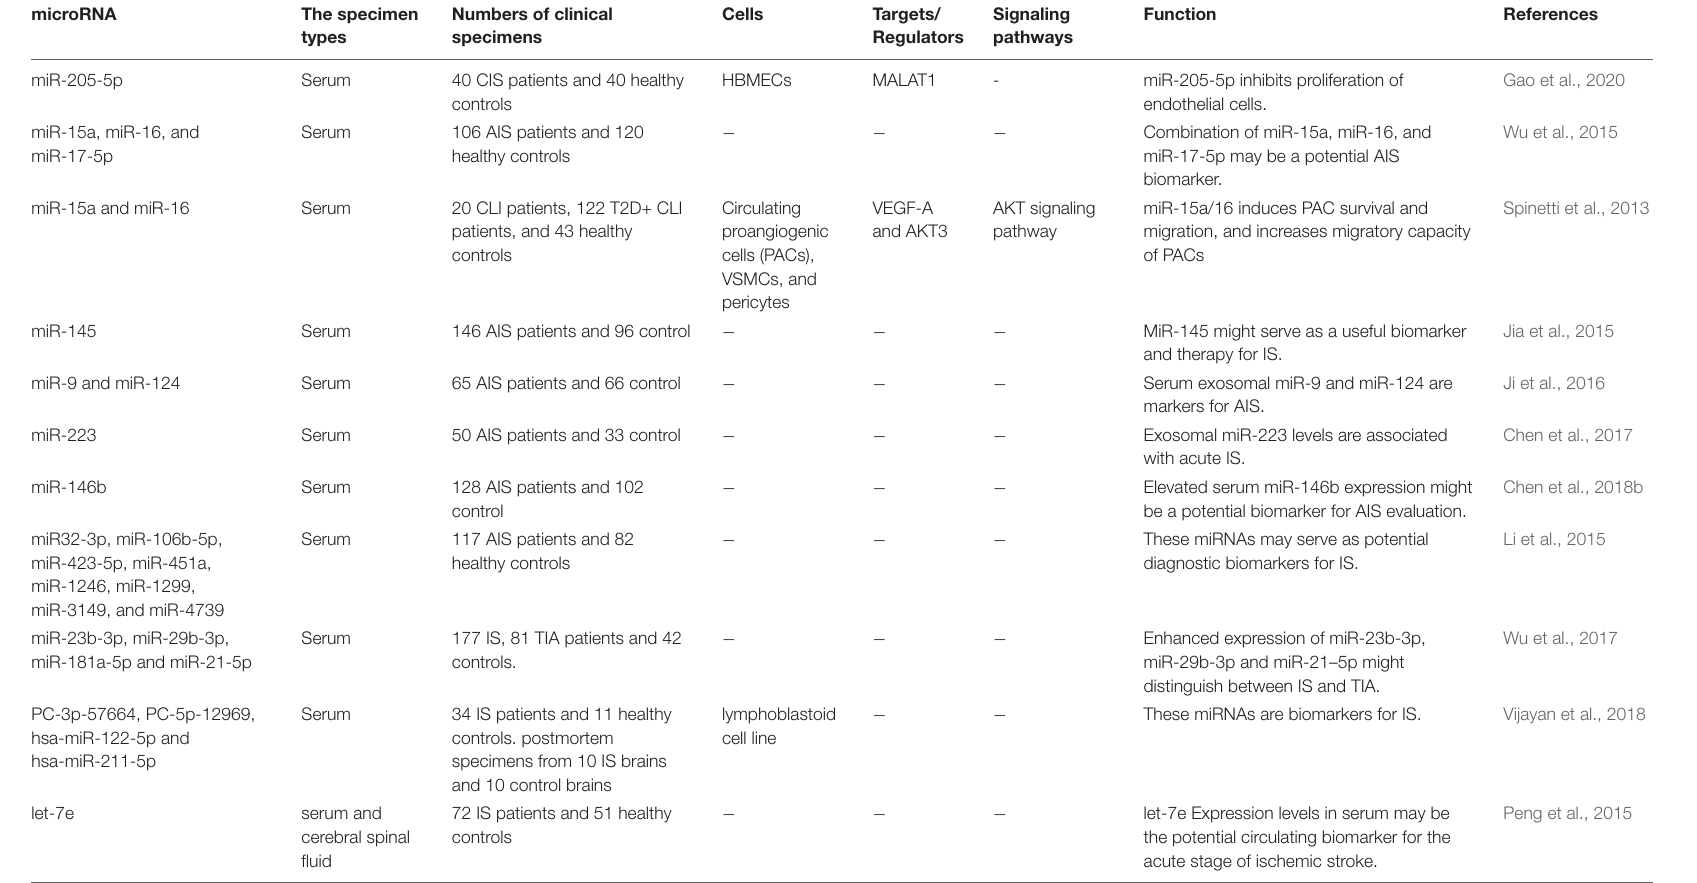
72 IS patients and 51 healthy controls